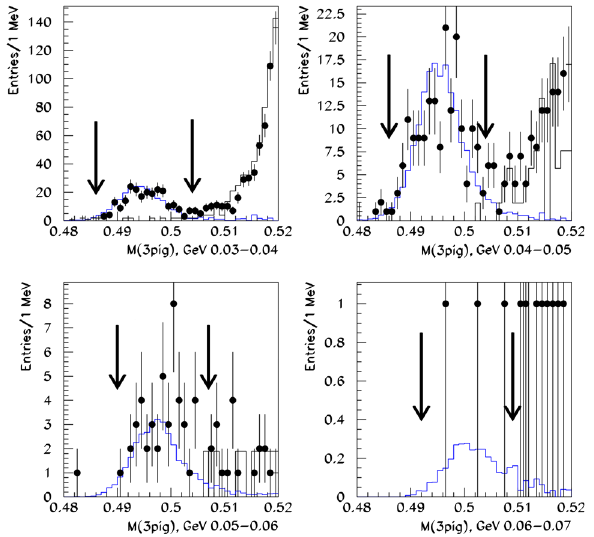
Fig. 7 Invariant mass distributions of the 3 πγ system for the data (black circles), signal decays (blue histogram) and main sources of the background (black histogram) for the different energy ranges of the photon in the decay K + → π + π − π + γ . The top left distribution is for the photon energy range 0.03–0.04 GeV, the top right one is for the range 0.04–0.05 GeV, the bottom left one is for the 0.05–0.06 GeV and the last one is for the 0.06–0.07 GeV. The arrows show the signal regions used in the analysis